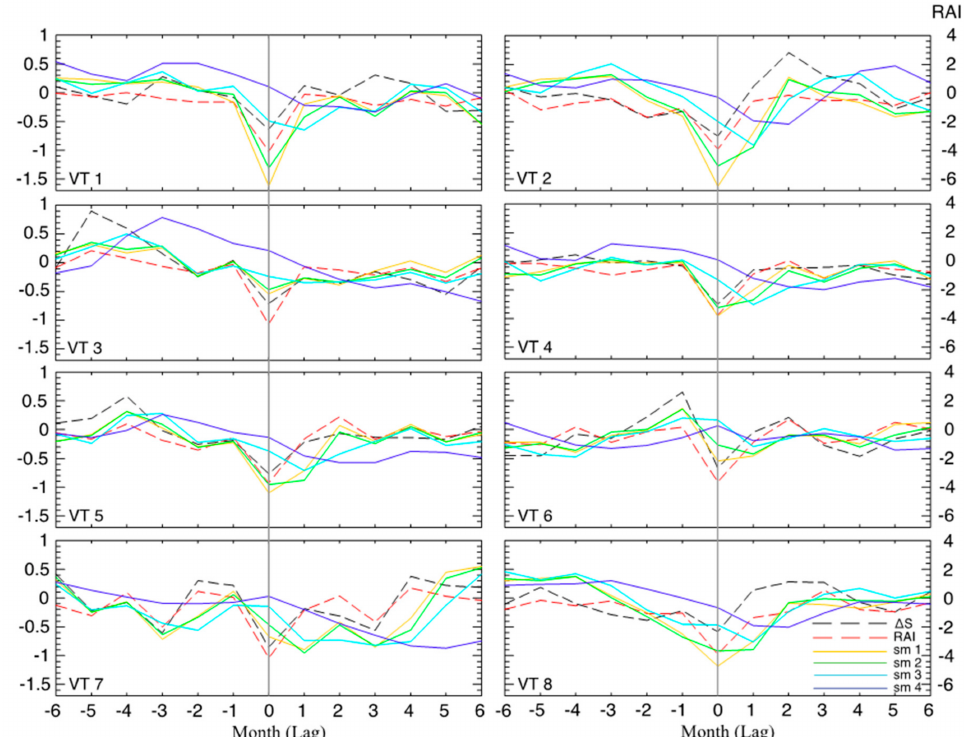
Figure 6. Results of composite analysis based on the ten minimum RAI cases for each vegetation type; ∆ S , black dotted line; RAI, red dotted line; soil moisture in the first layer (sm 1), solid yellow line; soil moisture in the second layer (sm 2), solid green line; soil moisture in the third layer (sm 3), sky blue solid line; and soil moisture in the fourth layer (sm 4), solid blue line. All the values from ∆ S and sm 1–4 are normalized and indicated on the left